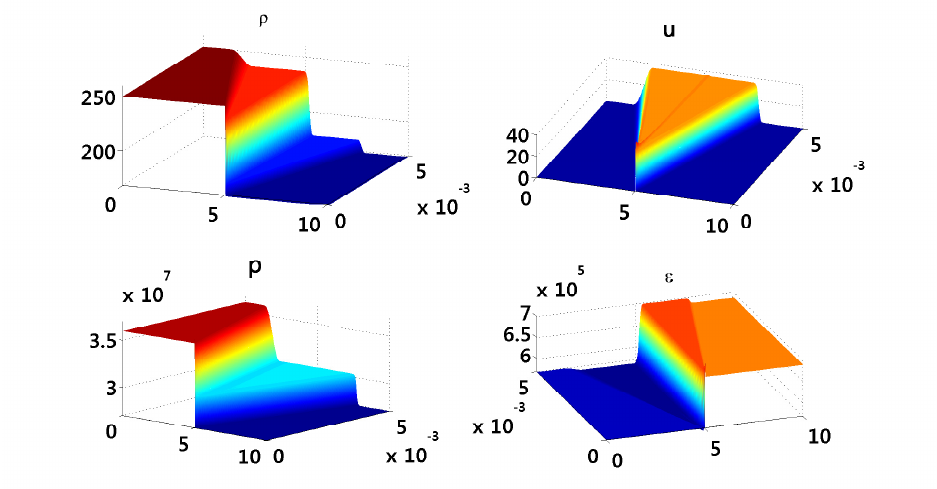
Figure 8. Test 4 (the Van der Waals gas): the space–time